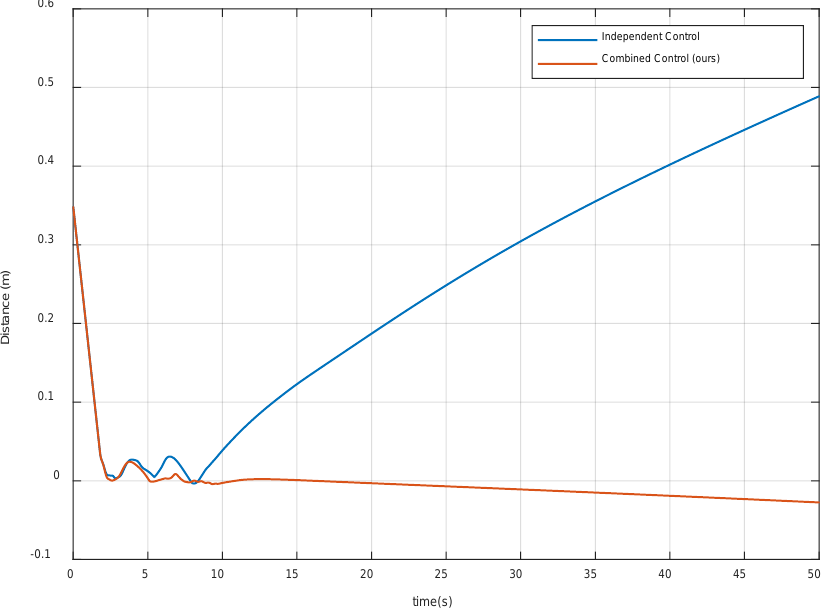
Figure 12. Distance magnitude between the contact plane and the target spacecraft surface.